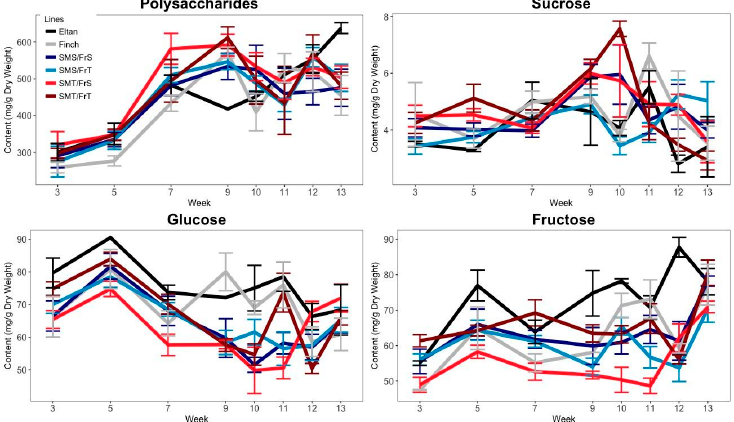
Figure 1. Changes in polysaccharide and simple carbohydrate content in wheat differing for snow mold and freezing tolerance after a cold treatment over 13 weeks at 4 °C. Plants 2019 , 8 , x FOR PEER REVIEW